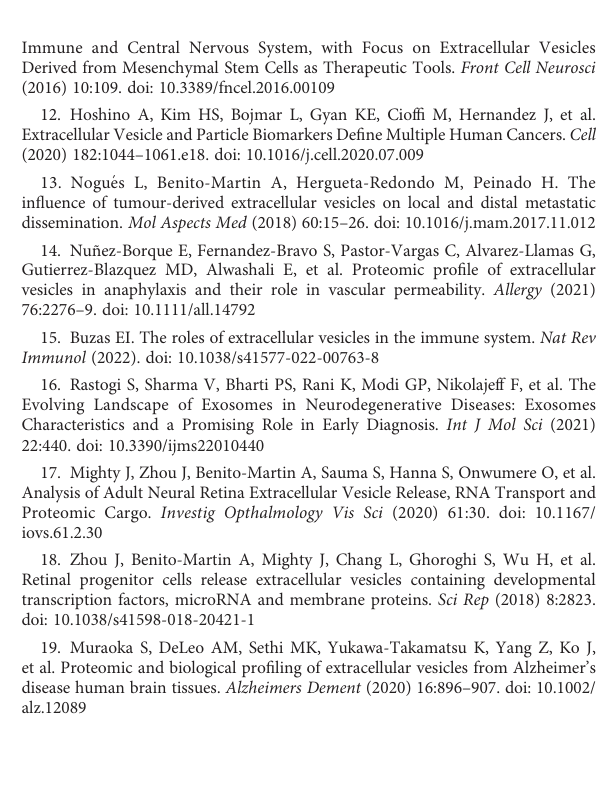
SUPPLEMENTARY FIGURE 1 Histology of non-diabetic and diabetic retina. Representative sample image of non-diabetic retinal slice showing (A) phase light microscopy of the retina and (B) DAPI labeling (ex 358/em 461). nuclear staining of the lamina. Representative sample retinal slice showing diabetic retina showing (C) phase microscopy and (D) DAPI nuclear staining of the lamina. Scale: 100um. SUPPLEMENTARY TABLE 1 List of proteins (264) exclusively detected in Diabetic retinopathy extracellular vesicles released from human retina tissue when compared with Nondiabetic EVs released by human retina tissue and the culture media. SUPPLEMENTARY TABLE 2 List of proteins (364) exclusively detected in Diabetic retinopathy tissue explants from human retina tissue. SUPPLEMENTARY TABLE 3 List of 228 proteins detected in Diabetic retinopathy extracellular vesicles when compared with diabetic retinopathy tissue explant secretome. SUPPLEMENTARY TABLE 4 List of 1112 proteins detected in Diabetic retinopathy urinary extracellular vesicles, and not detected in non-diabetic urinary extracellular